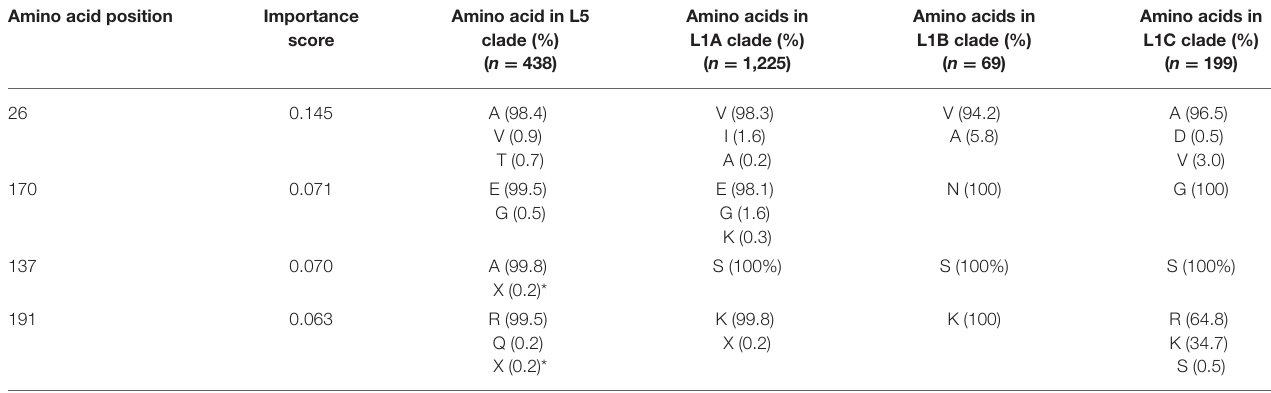
Amino acid position Importance